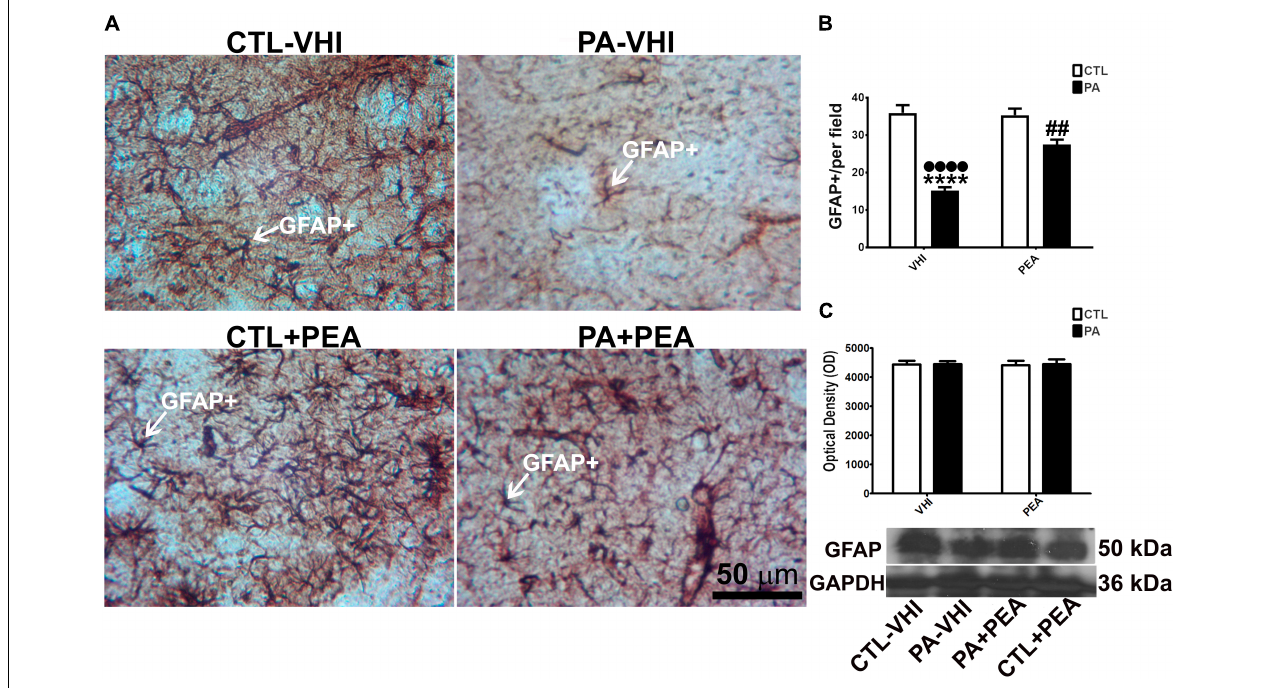
FIGURE 3 | GFAP + cells and protein expression level in the rat striatum. (A) Representative images of the dorsal striatum immunostained for glial fibrillary acidic protein (GFAP). The white arrow shows an astrocyte immunostained for GFAP. Scale bar: 50 µ m. (B) Number of the GFAP + cells measured per experimental group. (C) Optical density of the bands for GFAP protein expression level. Bars and error bars represent mean ± SEM. Two-way ANOVA followed by Tukey’s post hoc test. ∗∗∗∗ p < 0.0001, PA–VHI vs. CTL–VHI, •••• p < 0.0001, PA–VHI vs. PA+PEA and ## p < 0.005, PA+PEA vs. CTL–VHI. PEA had no effect on GFAP + immunostaining as there was no difference between CTL+PEA and CTL–VHI groups. Neither PA nor PEA affected GFAP protein level. CTL, control rats treated with vehicle; PA–VHI, rats subjected to PA and treated with vehicle; PA+PEA, rats subjected to PA and PEA treatment; CTL+PEA, control rats treated with